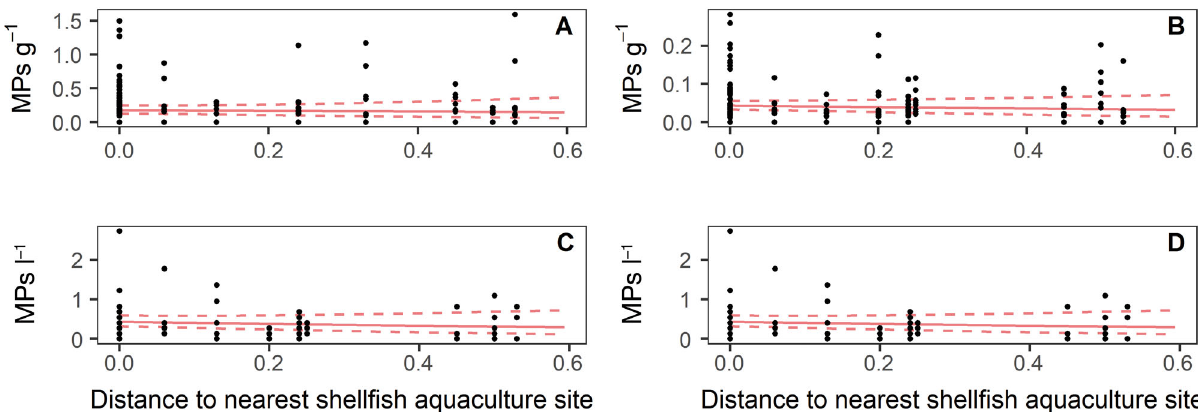
Fig. 6. Microplastic particle (MP) concentrations in (A) clams, (B) oysters, (C) water, and (D) sediment, plotted against shortest overwater distance to nearest shellfish aquaculture site. Concentrations for oysters are in terms of dry-tissue weight. All MP concentrations are adjusted for identification error and for background contamination. The solid red line indicates generalized linear mixed model (GLMM) fit, with random effects set to 0 and dry-tissue weight set to the average value for each of the shellfish species. The dashed red lines indicate the 95% confidence interval for the model fit. Distance to nearest shellfish aquaculture site did not significantly affect MP concentration in any of the models